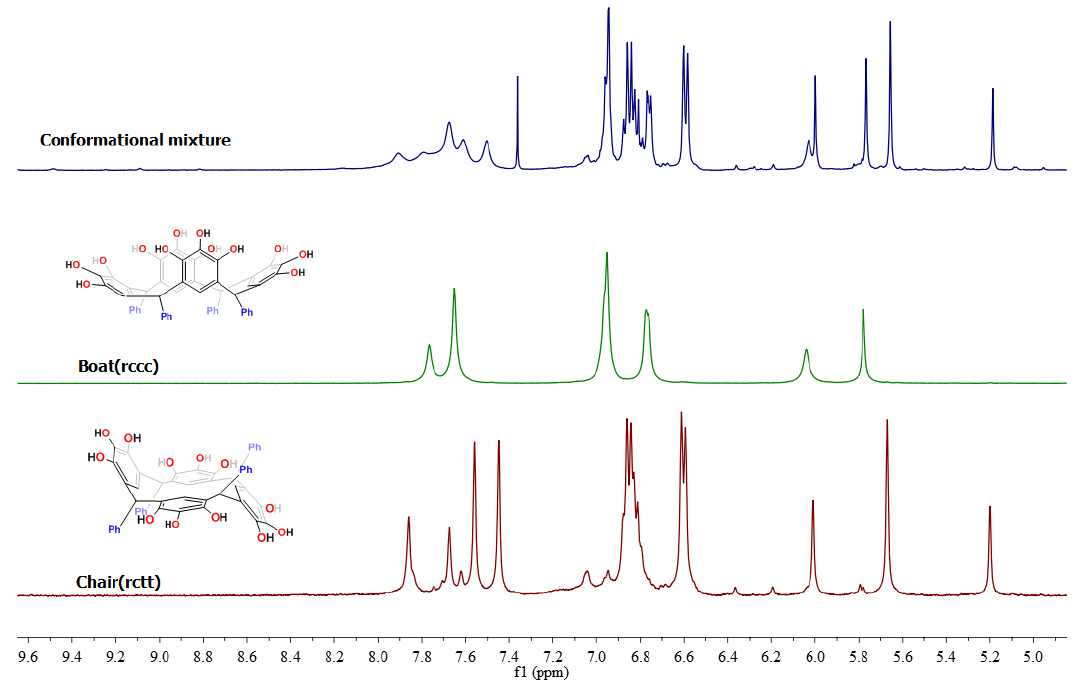
Figure 1. Comparative 1 H-NMR spectra of de products 2a and 2b in DMSO- d 6 at room temperature.